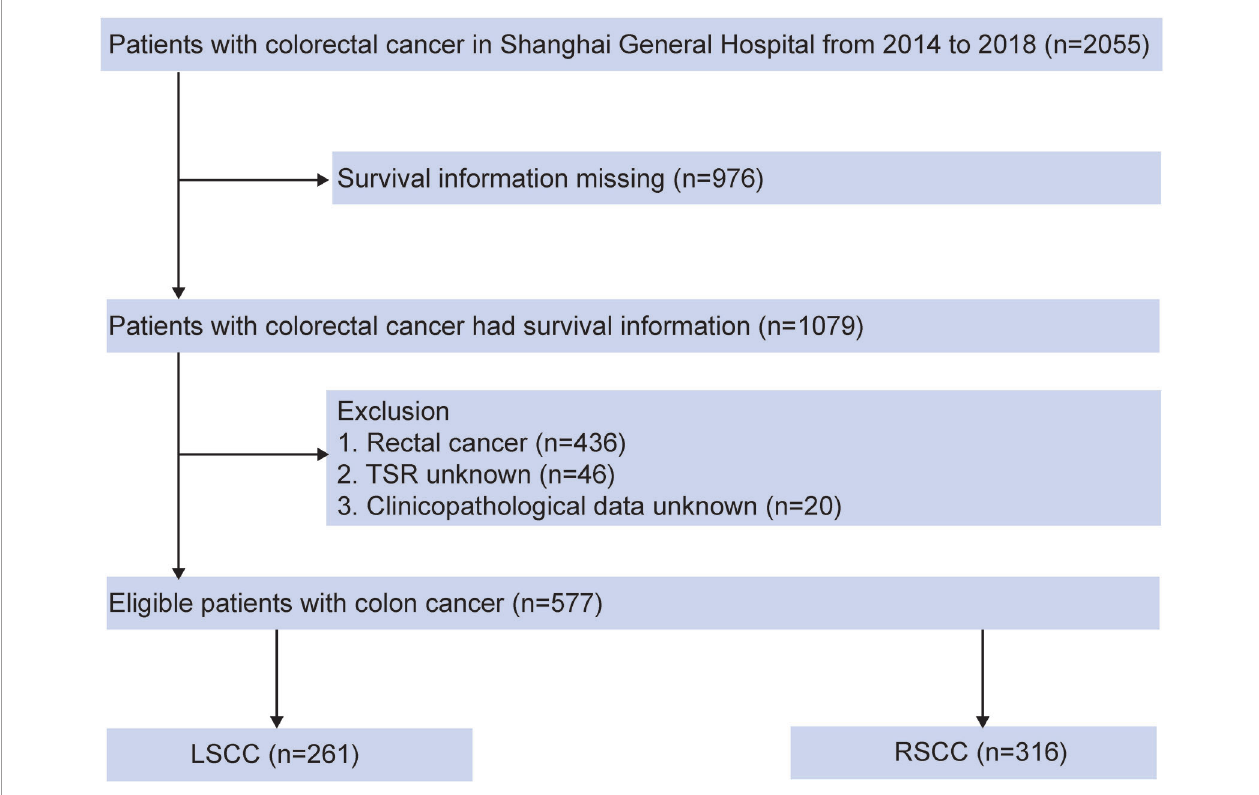
FIGURE 1 | Flowchart of CC patients in our